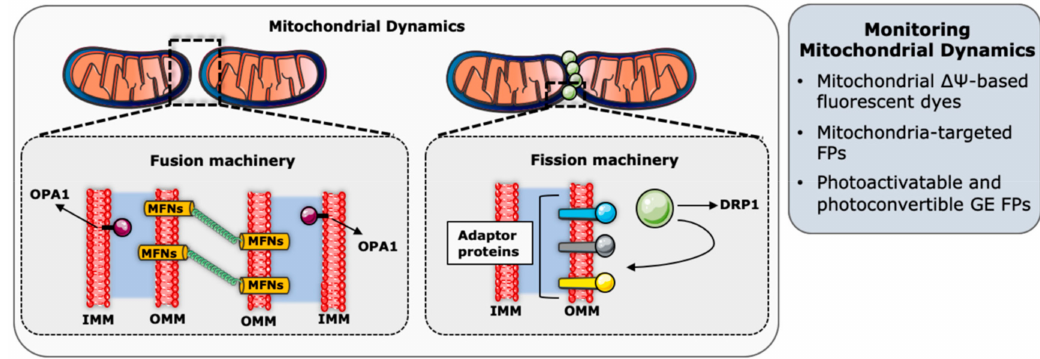
Figure 2. Probes to monitor mitochondrial dynamics. The major molecular players regulating these functions are symbolized within mitochondria. Key imaging-based approaches are listed in the grey box. OPA1, dynamin-likeGTPaseopticatrophy1; MFNs, mitofusin1andmitofusin2; DRP1, dynamin-related protein 1; IMM, inner mitochondrial membrane; OMM, outer mitochondrial membrane; ∆Ψ , membrane potential di ff erence; FPs, fluorescent proteins; and GE, genetically-encoded. The figure was generated with elements provided in the Servier Medical Art depository (https: // smart.servier.com / ) and are licensed under a Creative Commons Attribution 3.0 Unported License (CC BY